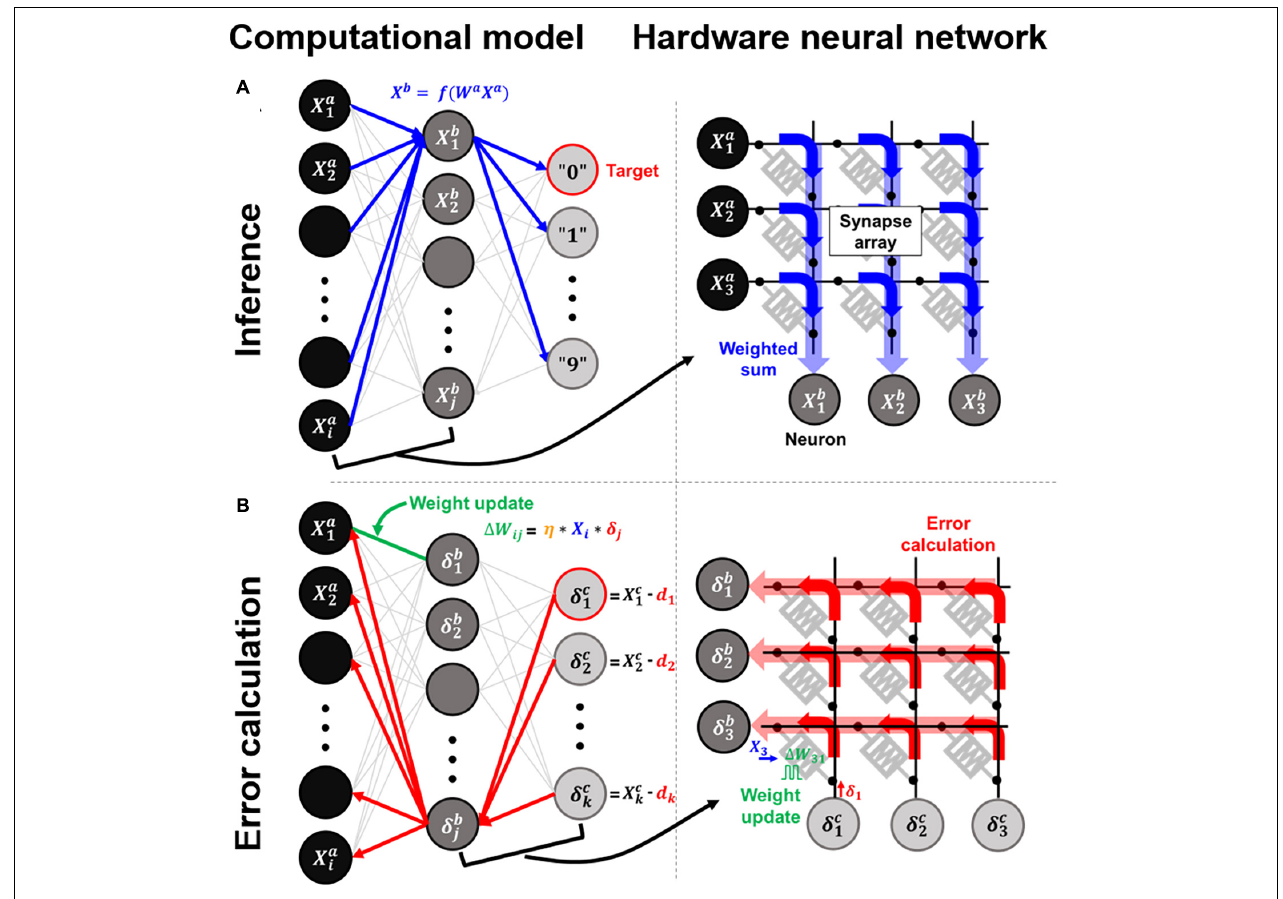
FIGURE 1 | Computational models and arrays of hardware neural networks for the (A) inference process and (B) error calculation